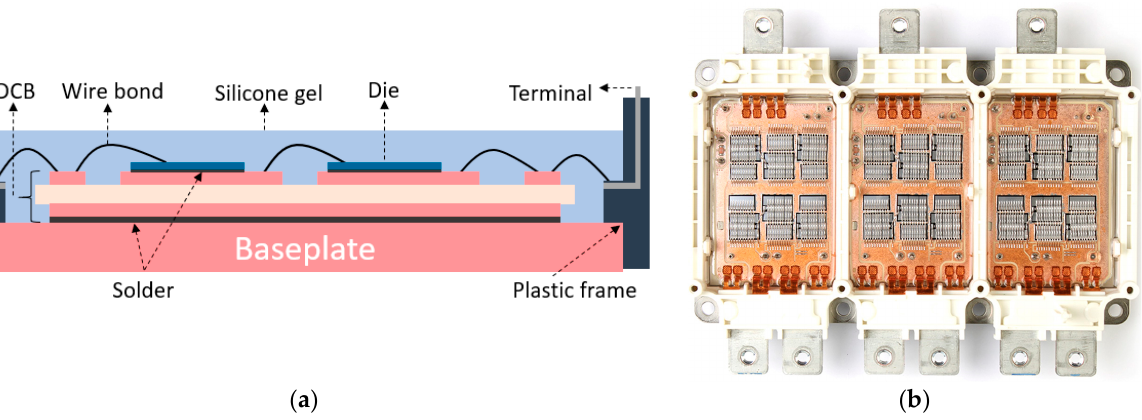
Figure 6. ( a ) Power module cross-section; ( b ) Open FS820R08A6P2B HybridPACK Drive [29].